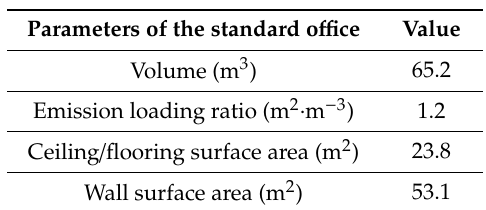
Table 5. Standard o ffi ce